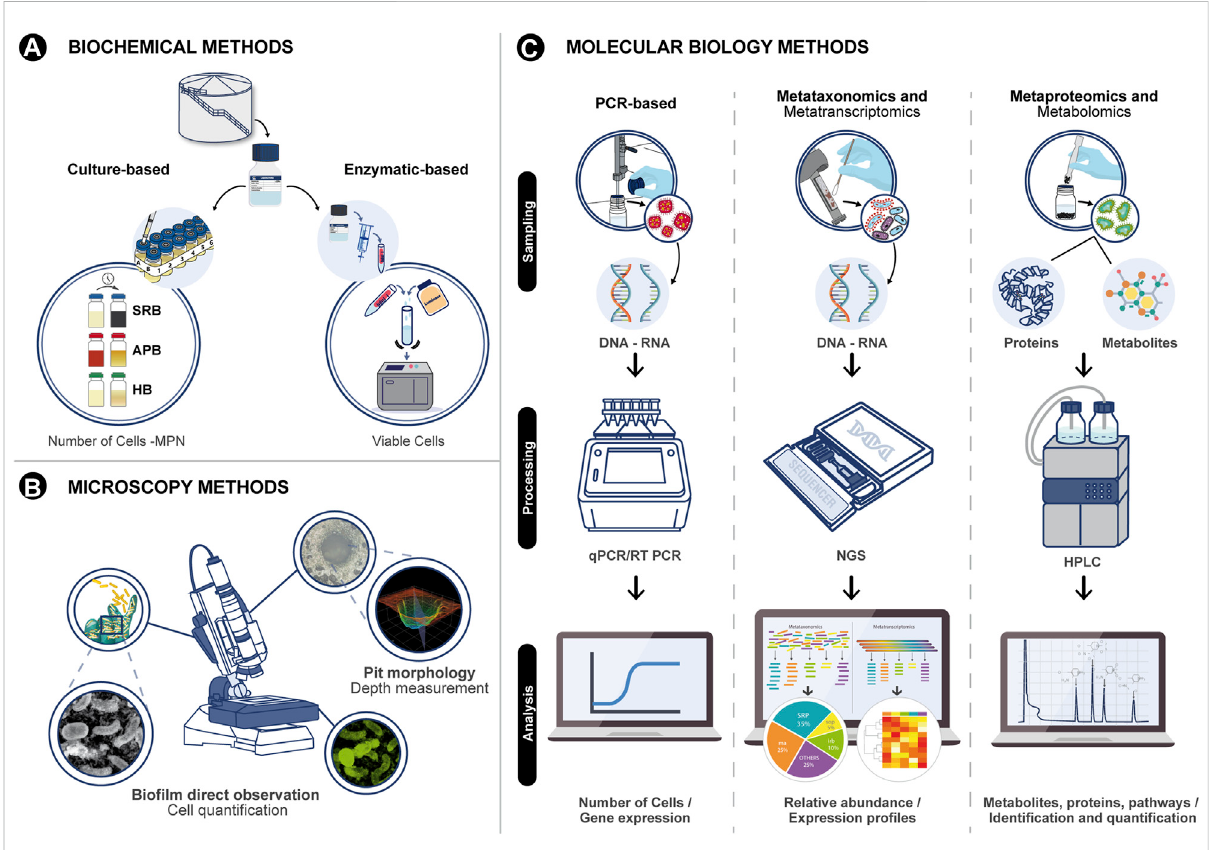
FIGURE 2 Overview of alternatives for monitoring microbial corrosion. (A) Methods based on testing physiological features of potentially corrosive microbes (B) ;microscopymethodsforevaluatingbio fi lmformationandstructure,determinationoflocalizedmetalloss,metallography,etc.,and (C) novel methods based on molecular biology for qualitative and quantitative analysis of corrosive